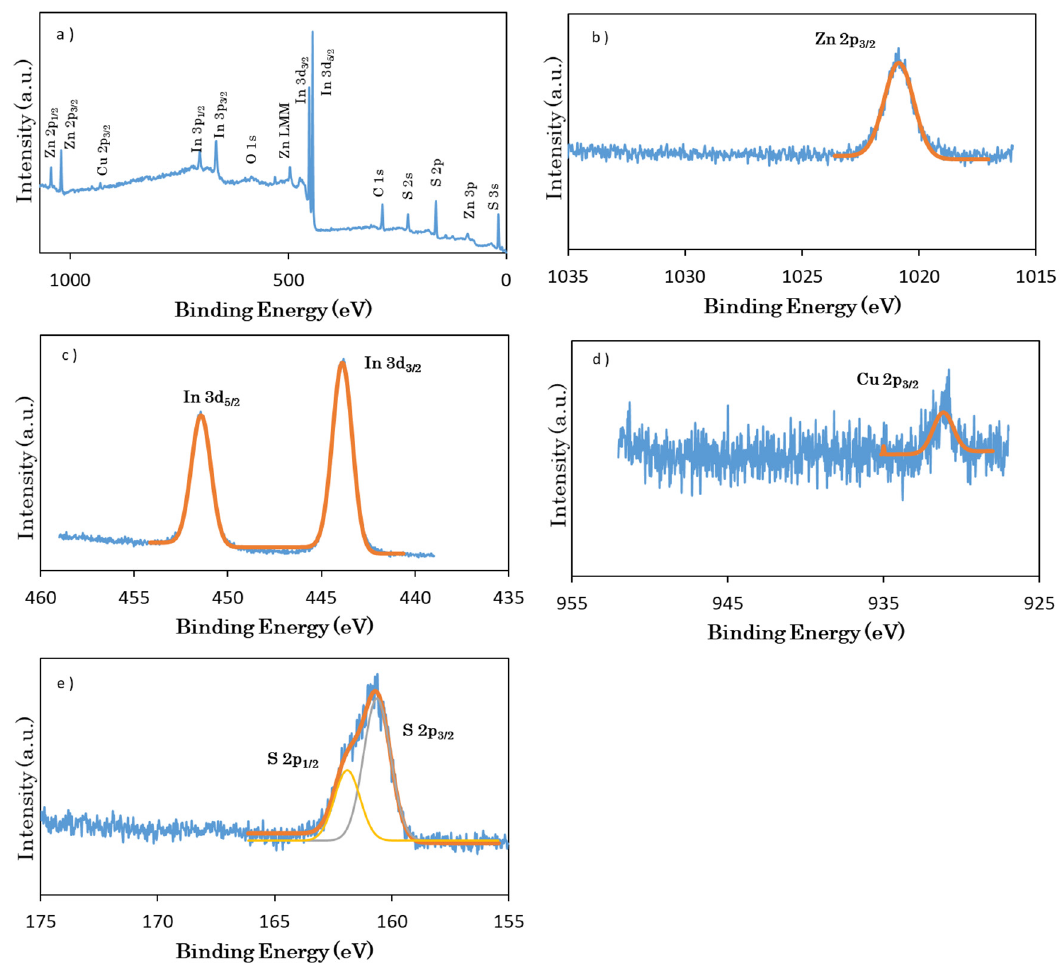
Figure 2. X-ray photoelectron spectroscopy (XPS) narrow and survey spectra of Zn 0.74 Cu 0.13 In 2 S 3.805 . ( a ) survey, ( b ) Zn, ( c ) In, ( d ) Cu and ( e ) S.